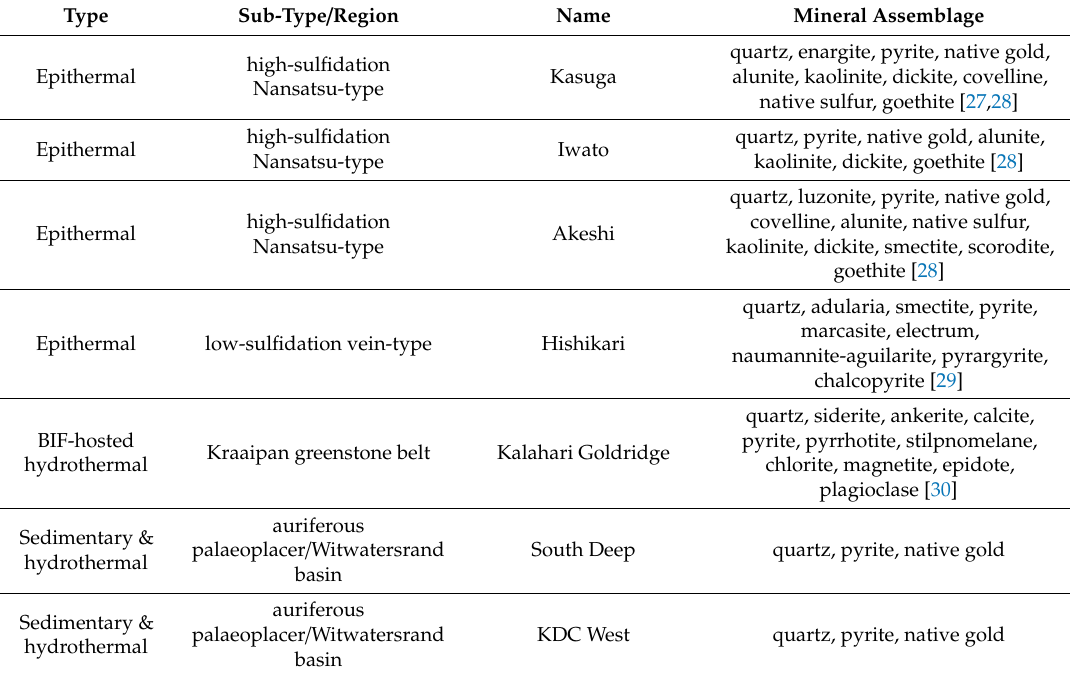
Table 1. General description of the studied Au